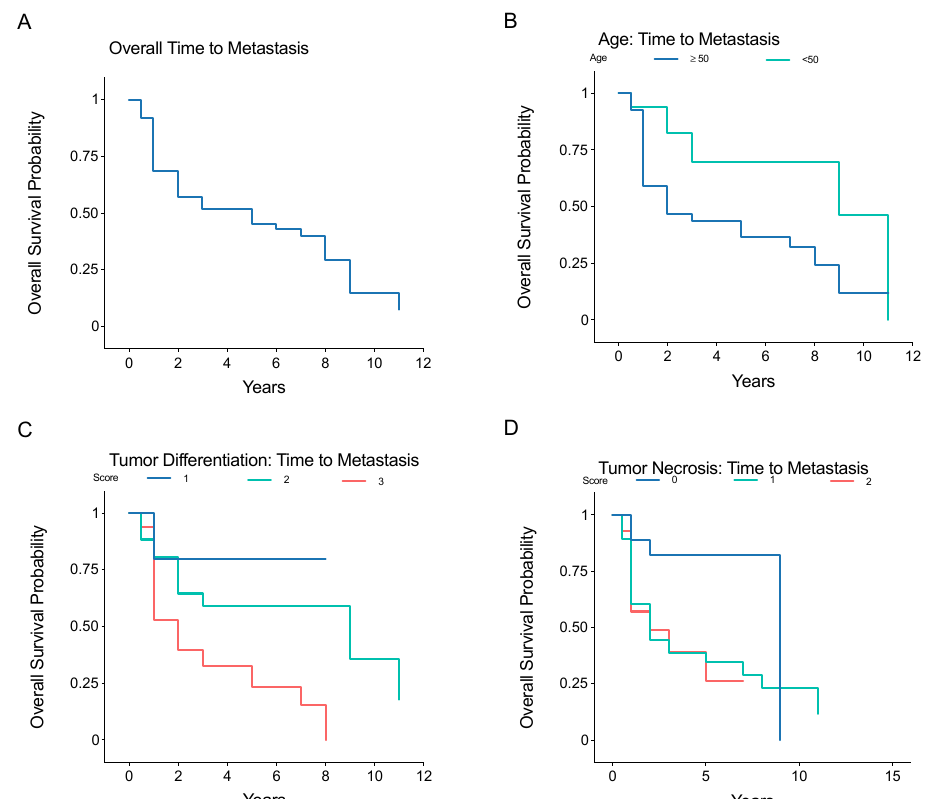
Figure 1. Kaplan–Meier analysis of metastatic-free survival after initial diagnosis of localized LMS, ( A ) overall time to metastasis, or stratified by ( B ) age greater or less than 50 years, ( C ) pathologist- reported tumor differentiation score (1, 2, or 3), or ( D ) pathologist-reported tumor necrosis score (0, 1, or 2).